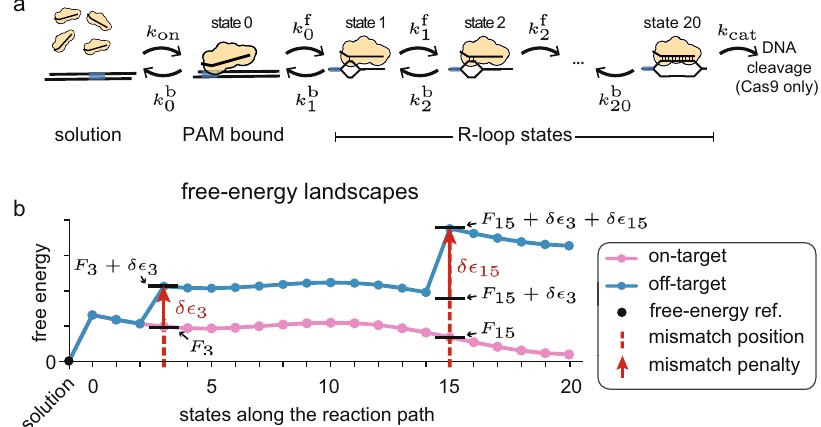
Fig. 1 The reaction scheme and the implications of the model assumptions. a The general microscopic reaction scheme for PAM (blue rectangle) binding from solution, followed by strand replacement and eventual cleavage (Cas9 only). The bound states are labeled 0-20, starting with the PAM bound state, and ending with the state having a fully open R-loop (20 bp hybrid). b An example on-target free-energy landscape F n (pink), and the resulting free-energy landscape when using our mechanistic-model assumptions on an off-target where mismatches enter the hybrid at length 3 and 15 bp (blue). Each mismatch (dashed red line) has an energetic cost ϵ n (red arrow) added onto the free energy of all later R-loop states. The solution state is chosen as a reference for the free energy, and set to 0 k B T (black